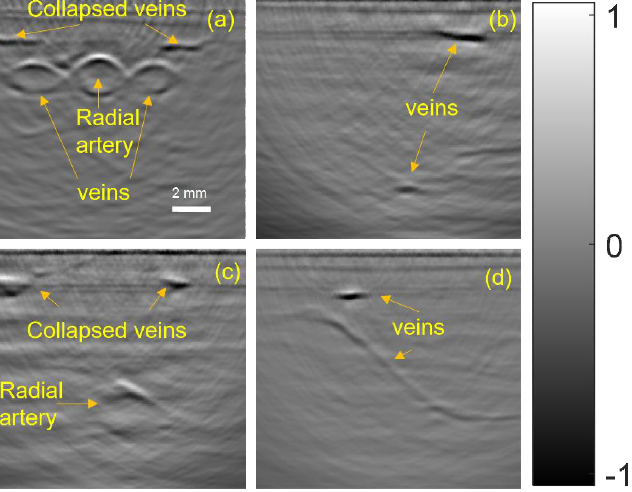
Figure 8. Optoacoustic images of the blood vessels in a human wrist, at different depths and orientations. A cross-section of the radial artery can be seen clearly in real time at depths up to 7 mm, as in ( a , c ). A deep vein can be seen in ( b ) at a depth of 8 mm. In ( d ), we can see a vein diving from 3 to 7 mm in a longitudinal cross-section. The scale bar in subfigure ( a ) applies to all